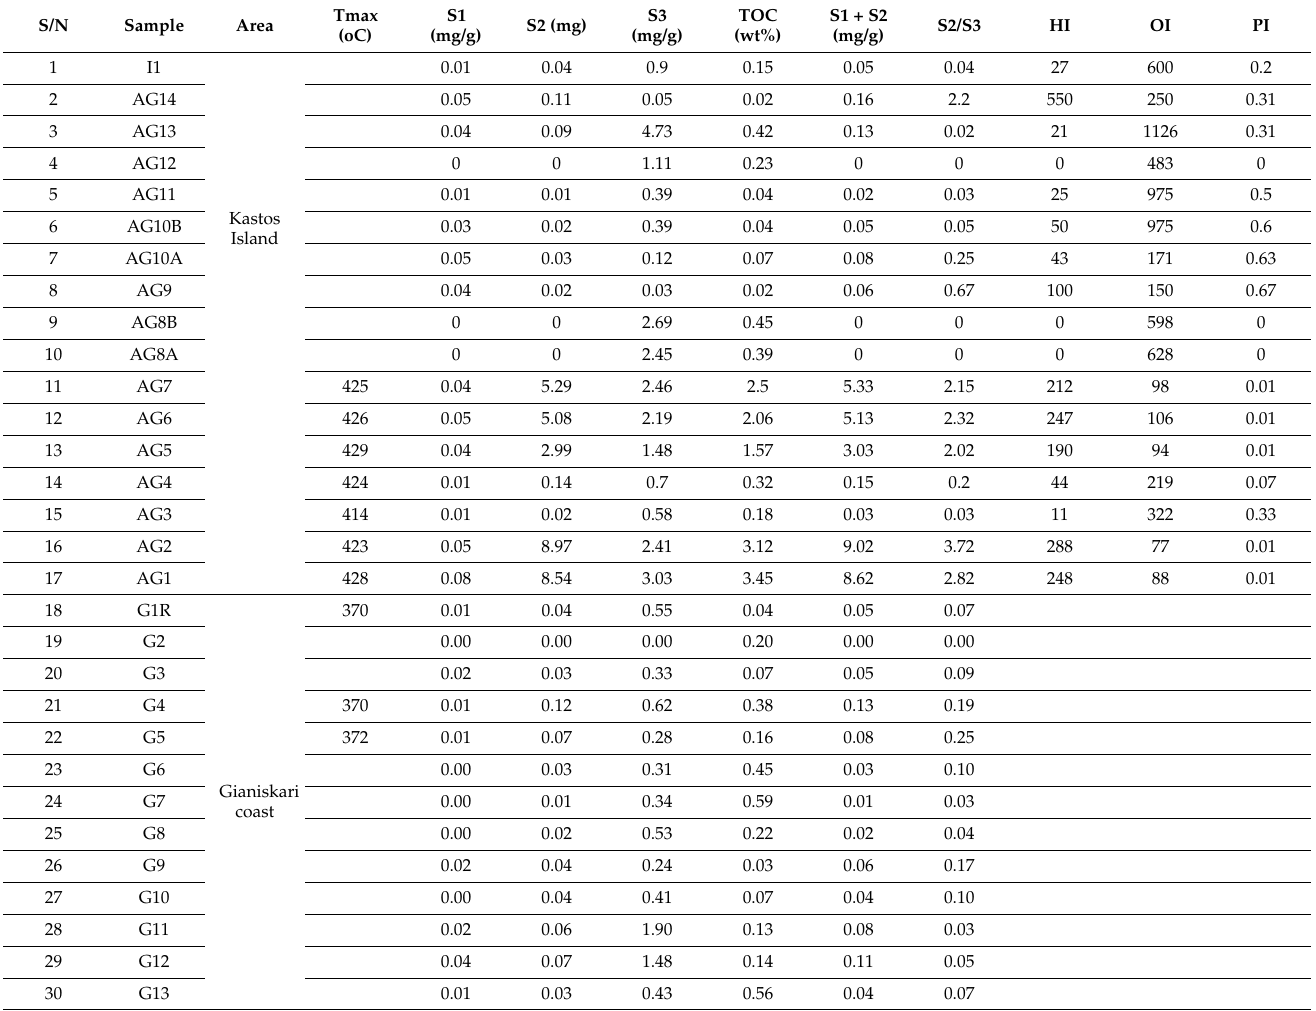
Table 1. Geochemical indices based on Rock-Eval VI analysis from samples of Kastos Island (17 samples), Araxos peninsula (Gianiskari coast (31 samples)), Gotzikas section (8 samples), and Ioannina well (6